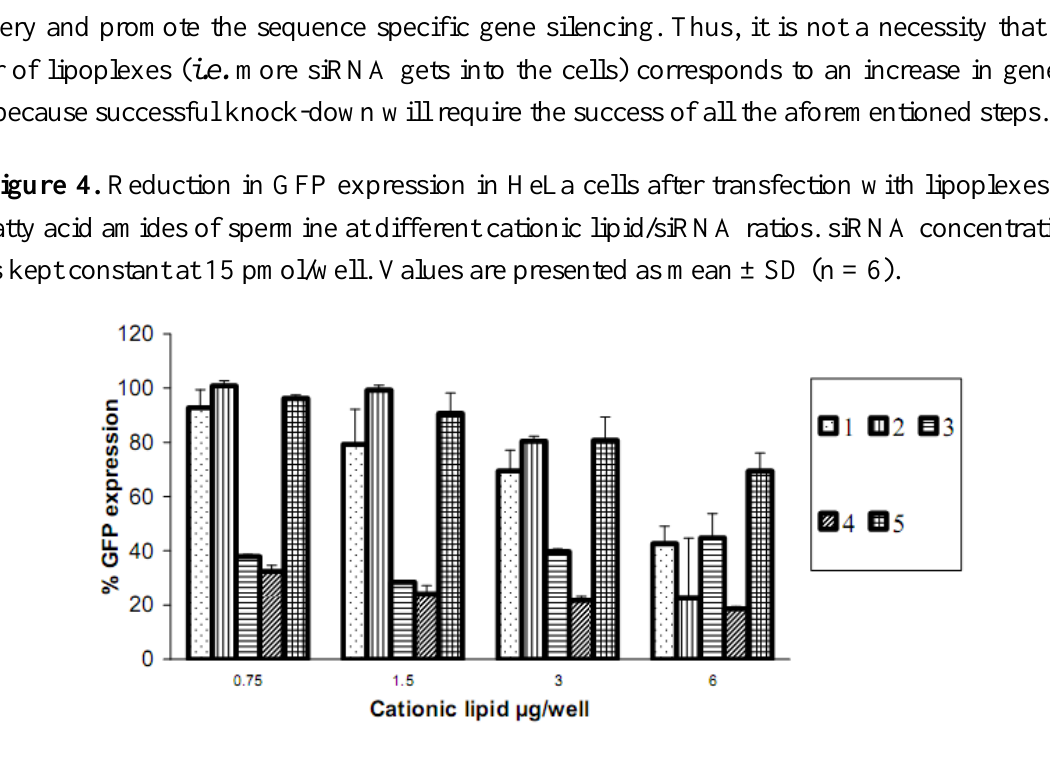
Figure 5. Comparison of reduction in GFP expression in HeLa cells (knock-down) at their optimal cationic lipid/siRNA ratios (shown as m g cationic lipid/15 pmol siRNA/well) and compared with the commercially available transfection agents Lipofectamine 2000 (2 m L/well) and TransIT TKO (4 m L/well). Values are presented as mean ± SD (n = 6) using erucoyl (6 m g/well), linoleoyl (1.5 m g/well), oleoyl (6 m g/well), and stearoyl (6 m